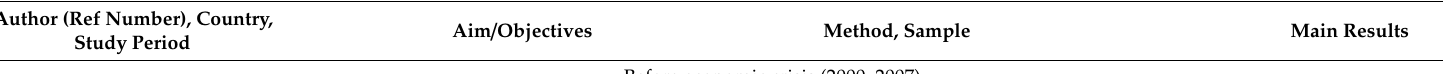
Table 3. Main features and results of the nine longitudinal quantitative studies included in the scoping review about occupational health and safety of immigrant workers in Italy and Spain